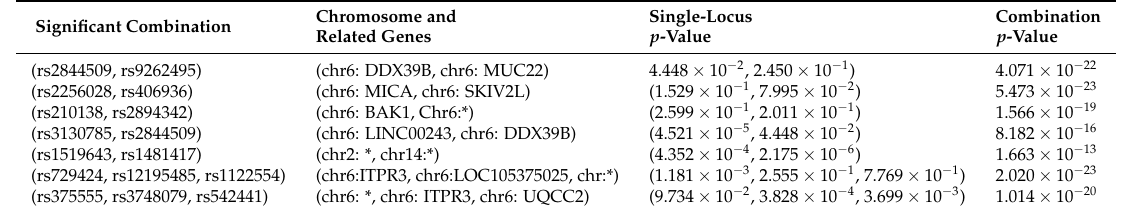
Table 3. Significant two-locus and three-locus combination identified by HiSeeker on WTCCC CD data. Significant Combination